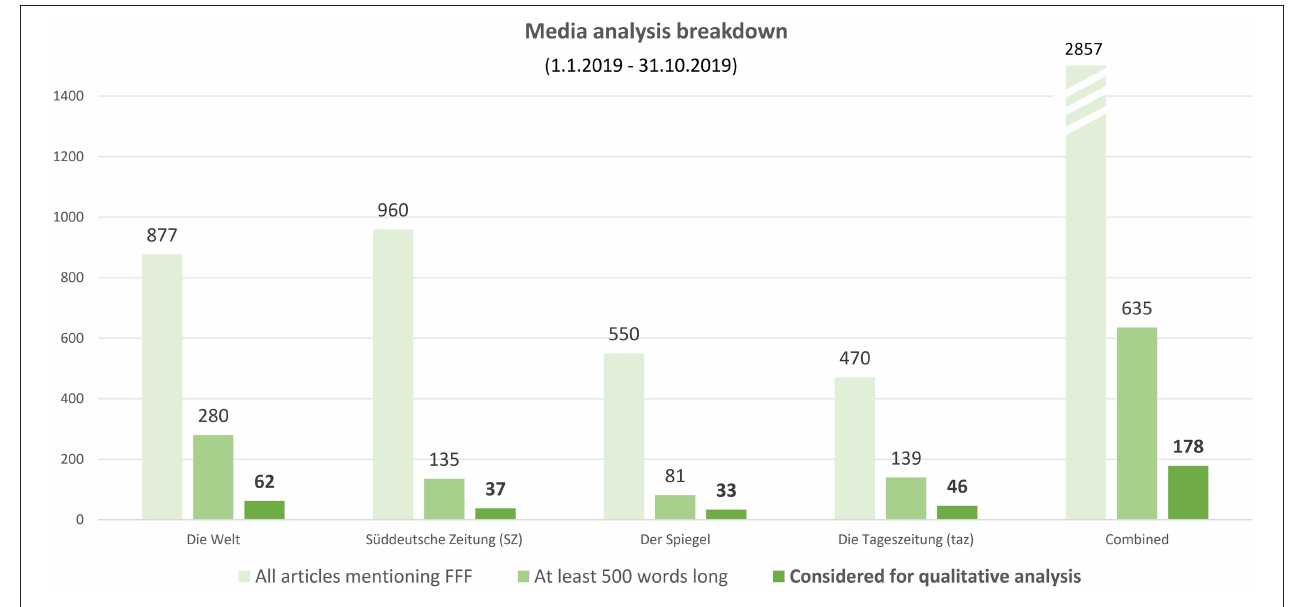
FIGURE 1 | Articles from four newspapers scanned and used for the media analysis.